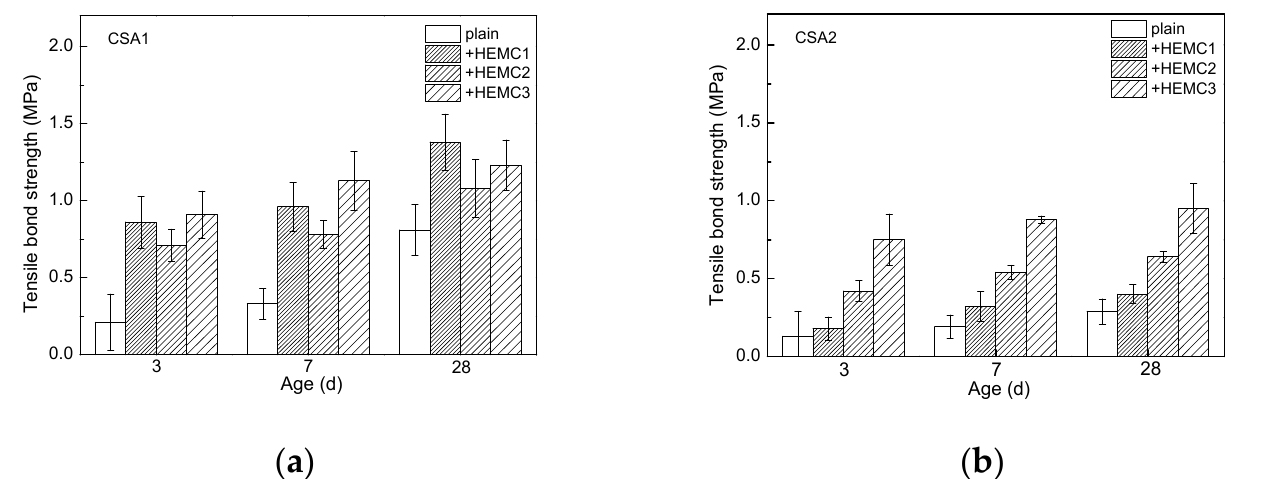
8 of 13 modified CSA2 cement mortar, meaning MS/DS had no significant effect on the flexibility of CSA2 cement mortar at early ages. At the age of 28 days, the ratio of compressive strength to flexural strength in HEMC2-modified CSA2 cement mortar was lower than that of HEMC1-modified CSA2 cement mortar. That means that HEMC with higher MS/DS can improve the flexibility of CSA2 cement mortar at later ages. At all curing ages, the ratio of compressive strength to flexural strength in HEMC3-modified CSA2 cement mortar was lower than that in HEMC2-modified CSA2 cement mortar. This means that the addition of PAAm enhances the positive effect of HEMC2 on the improvement of flexibility of CSA2 cement mortar. ( a ) ( b ) Figure 4. The ratio of compressive strength to flexural strength of CSA cement mortars with and without HEMCs at different curing ages: ( a ) CSA1, ( b ) CSA2. 3.2.4. Tensile Bond Strength The tensile bond strength of CSA cement mortars with and without HEMCs is illustrated in Figure 5. It is clear that the tensile bond strength of CSA1 cement mortar is higher than that of CSA2. HEMCs can increase the tensile bond strength of CSA cement mortars, but the effect of different HEMCs in CSA1 and CSA2 cement mortar varies. For example, the tensile bond strength of HEMC1-modified CSA1 cement mortar was higher than that of HEMC2-modified CSA1 cement mortar. This means that the lower MS/DS of HEMC contributes to the improvement of tensile bond strength. Meanwhile, the tensile